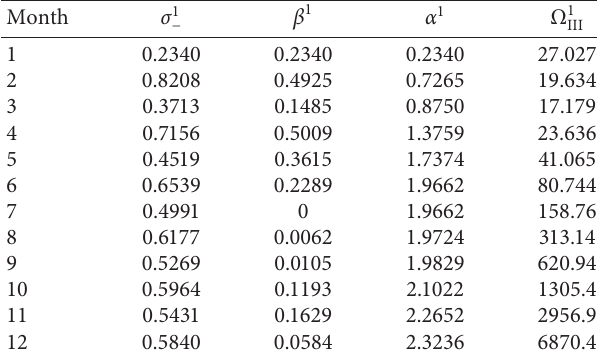
Table 2: Indicators of violence level